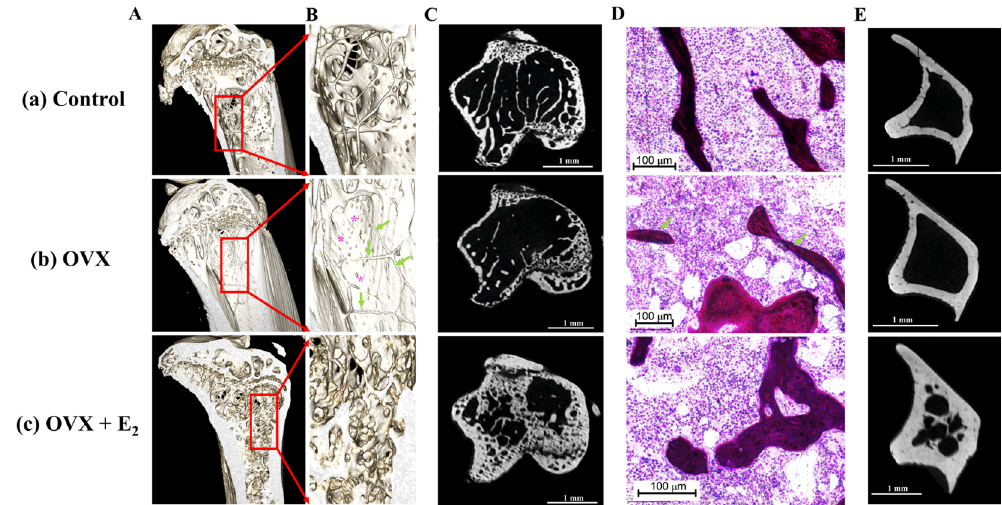
Figure 6. ( A ) Representative reconstructed 3D models following µCT scanning of ( a ) control, ( b ) OVX and, ( c ) OVX + E 2 experimental groups. ( B ) ( a – c ) Increased magnification reveals substantial loss of bone tissue in the OVX group despite ingestion of a high fat diet enriched with ω -9. Green arrows indicate the presence of few, and thin trabeculae within the proximal tibia, exposing the cortex behind (purple asterisks). The reduction in bone tissue is also displayed in the µ CT scans of the proximal tibia shown in ( C ) ( b ) and when compared to the control ( C ) (a) and OVX + E 2 animals ( C ) ( c ). ( D ) Histological analysis revealed fewer and thinner trabeculae (green arrows) in the OVX group of animals. ( E ) Notably, an increased cortical thickness was observed in the OVX + E 2 group when compared to both the control and OVX samples.